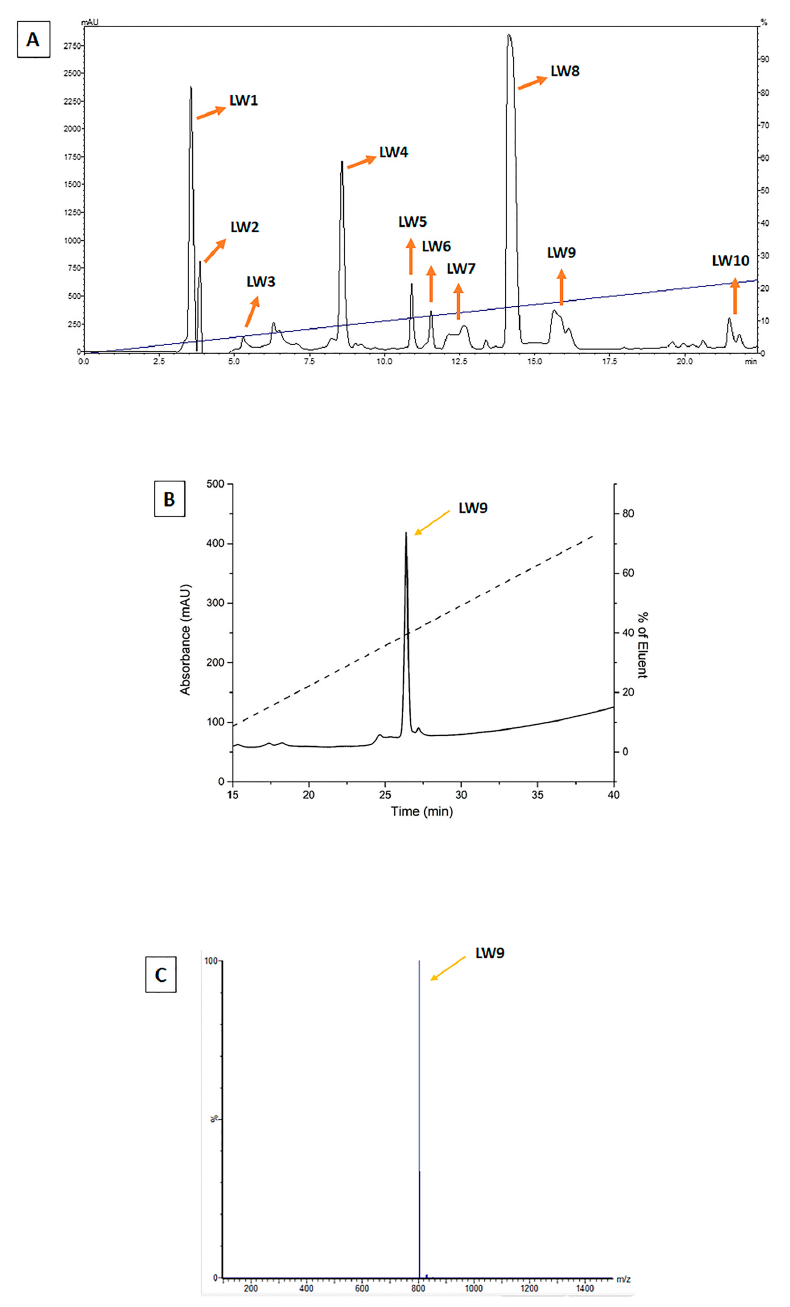
Figure 2. Purification profile of molecules isolated from PnV fractions by high-pressure liquid chromatography (HPLC). Panel ( A ) shows the HPLC purification of PnV fractions F1 (low weight) and F2 (intermediate weight), yielding ten different subfractions (LW1–LW10). ( B , C ) show the ion exchange chromatographic profile and the mass spectroscopy, respectively, of LW9, which revealed that the fraction have a satisfactory degree of purity.